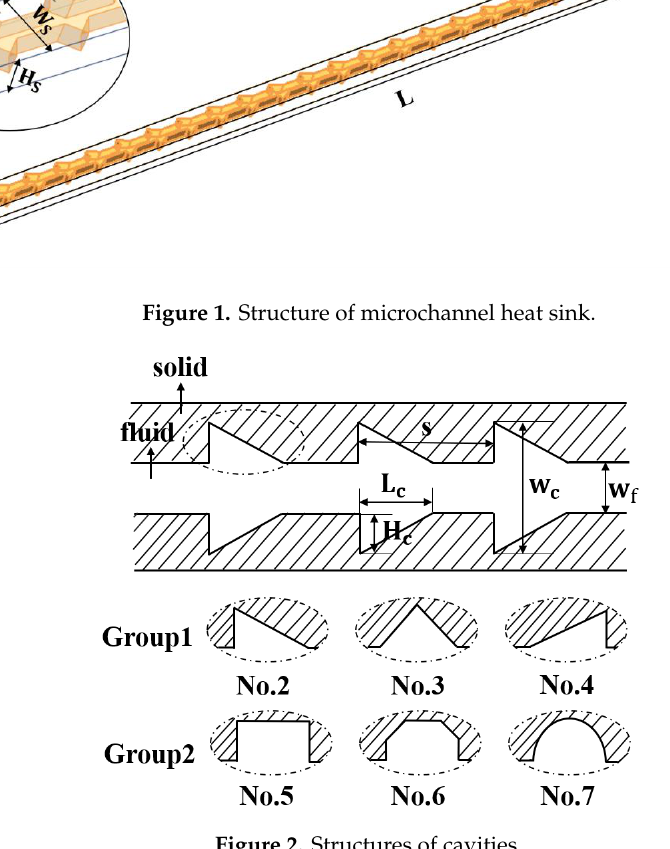
Figure 2. Structures of cavities.